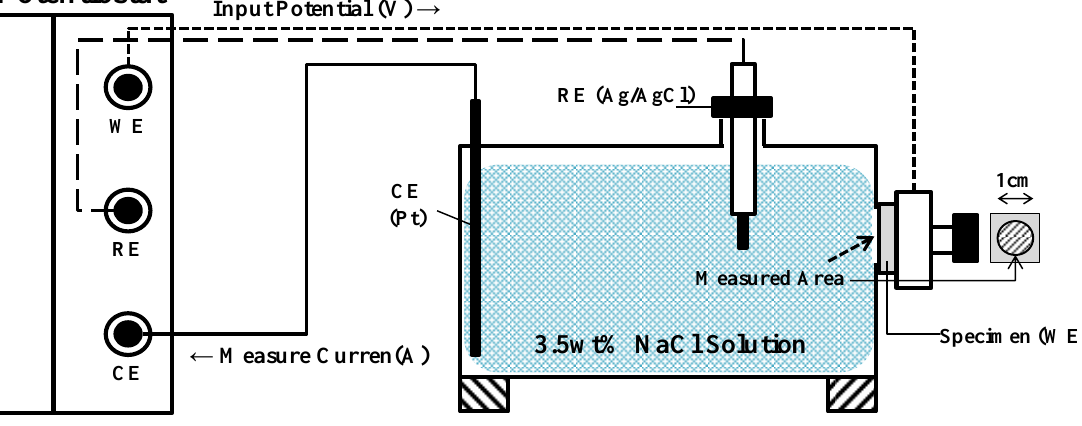
Figure 2. Schematic diagram for test setup. WE: working electrode; CE: counter